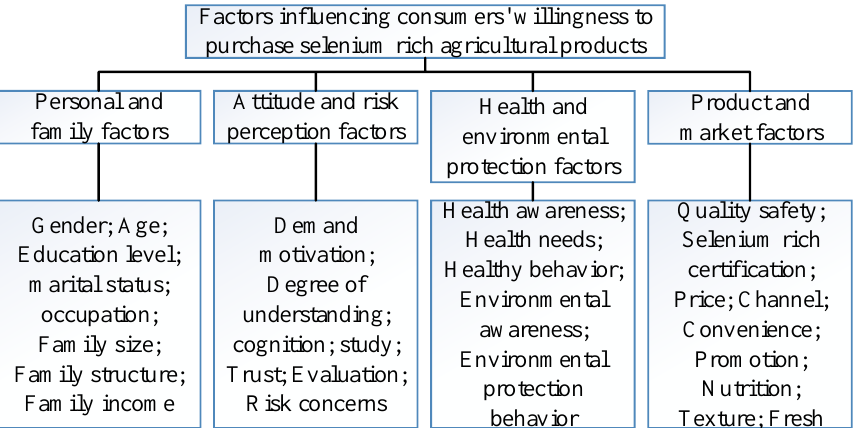
Figure 7. Factors influencing consumers’ willingness to buy enough organic agricultural products.